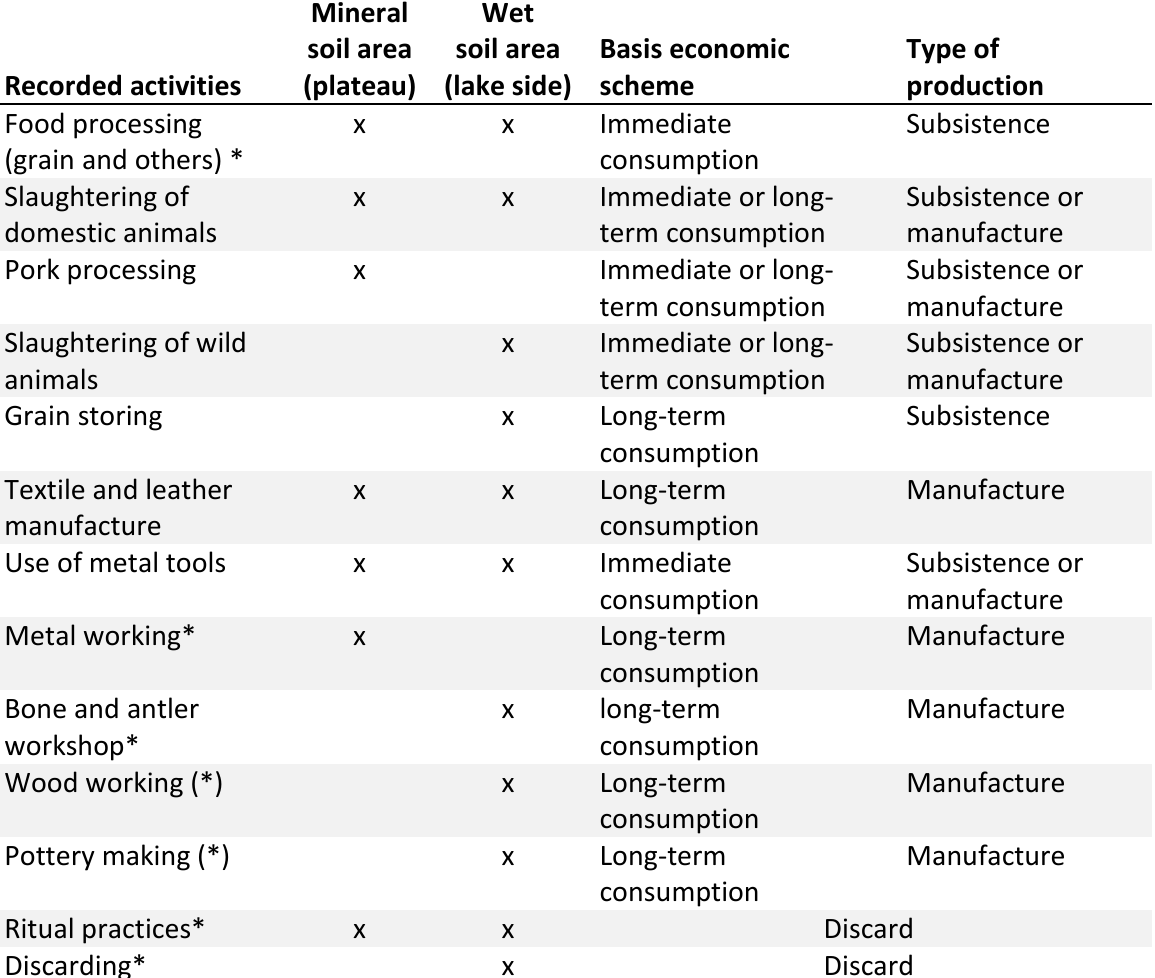
Table 3. Main productive tasks documented during the Únětice occupation in Bruszczewo. * activities also evidenced by the macro-lithic